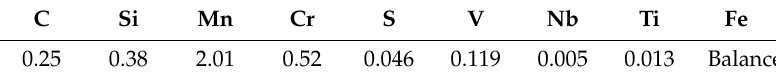
Table 1. Chemical compositions of the Nb-V-Ti free-cutting steel in